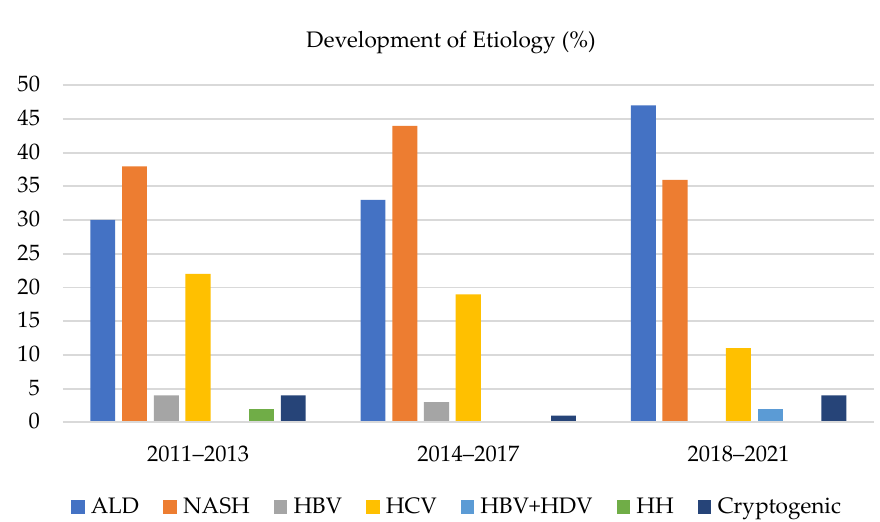
Figure 2. Overview of etiologies in % according to the studied time periods. A continuously increasing proportion of ALD-related HCC in the cohort and a nearly linear decrease in HCV as the etiological factor of HCC are shown.